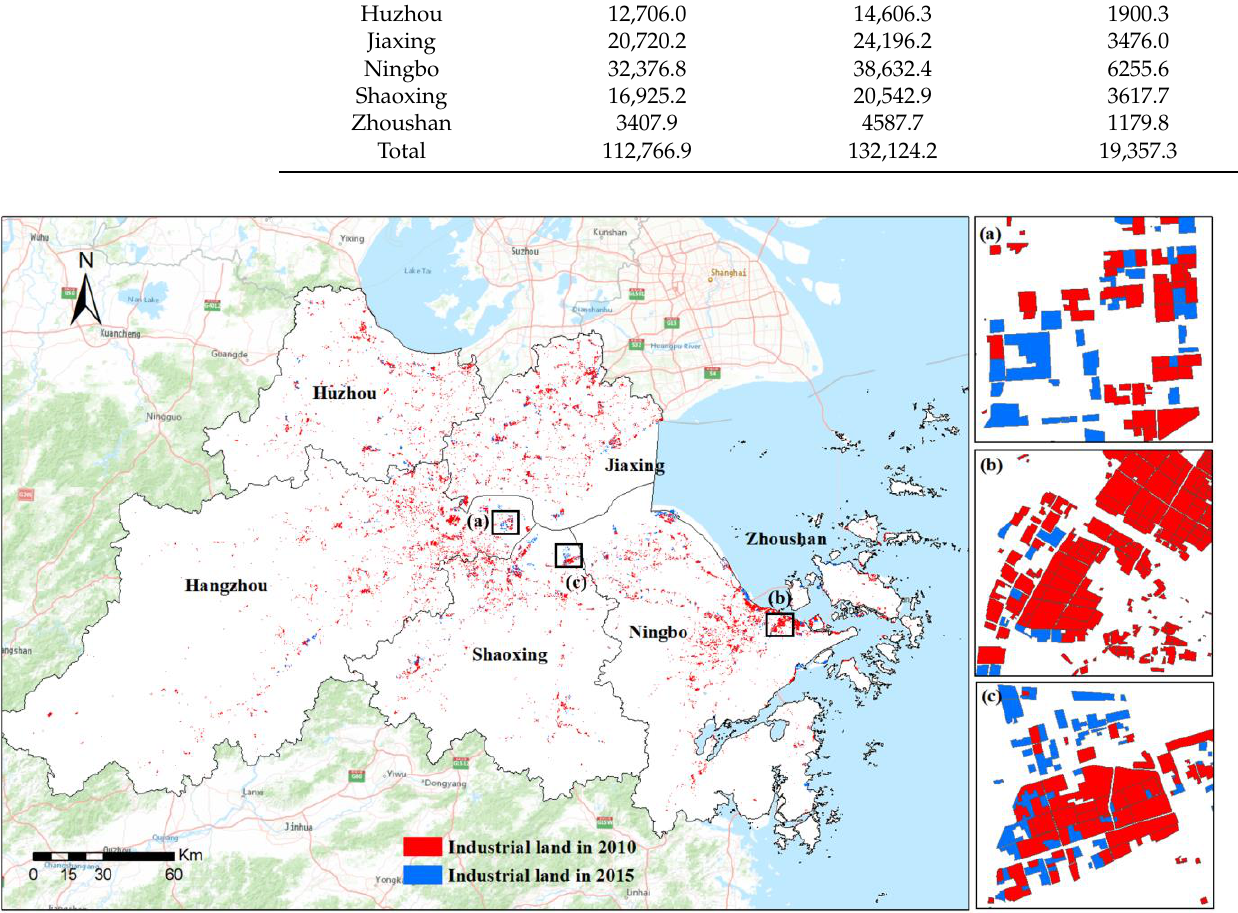
Figure 7. Spatial distribution of industrial land across the UAHB from 2010 to 2015: ( a ) Da jiangdong Economic Development Zone, ( b ) Ningbo Economic Development Zone, ( c ) Shangyu Economic Development Zone.